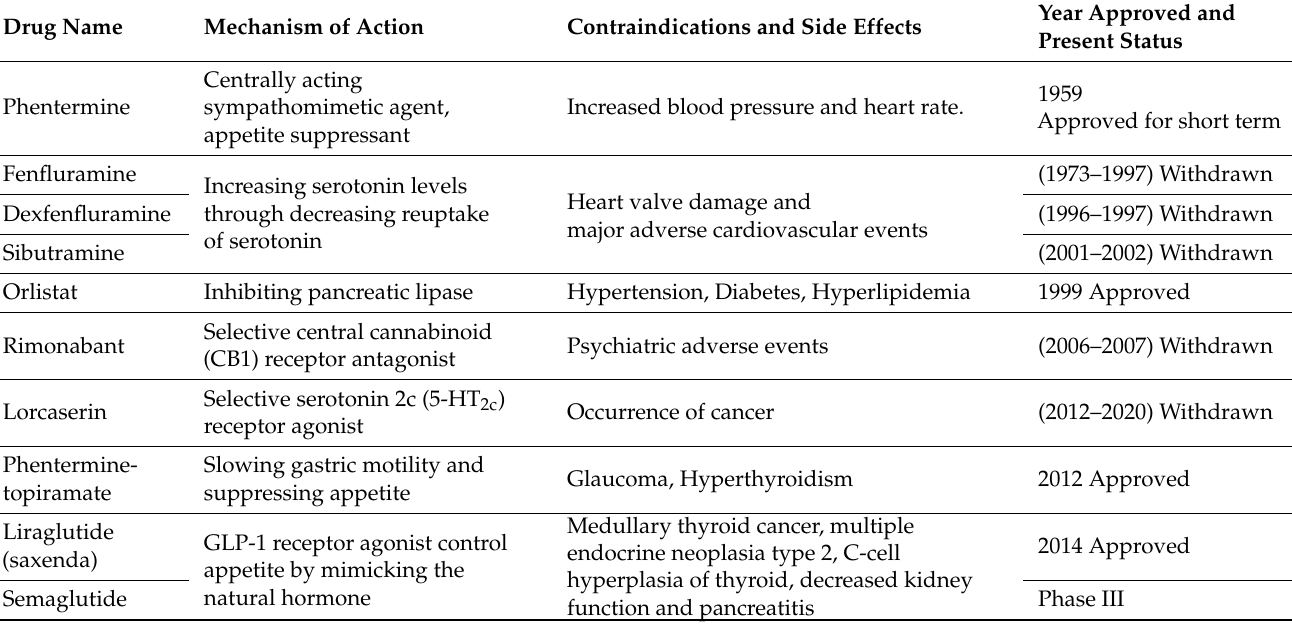
Table 1. List of pharmaceutical drugs and their present status. (Adapted from